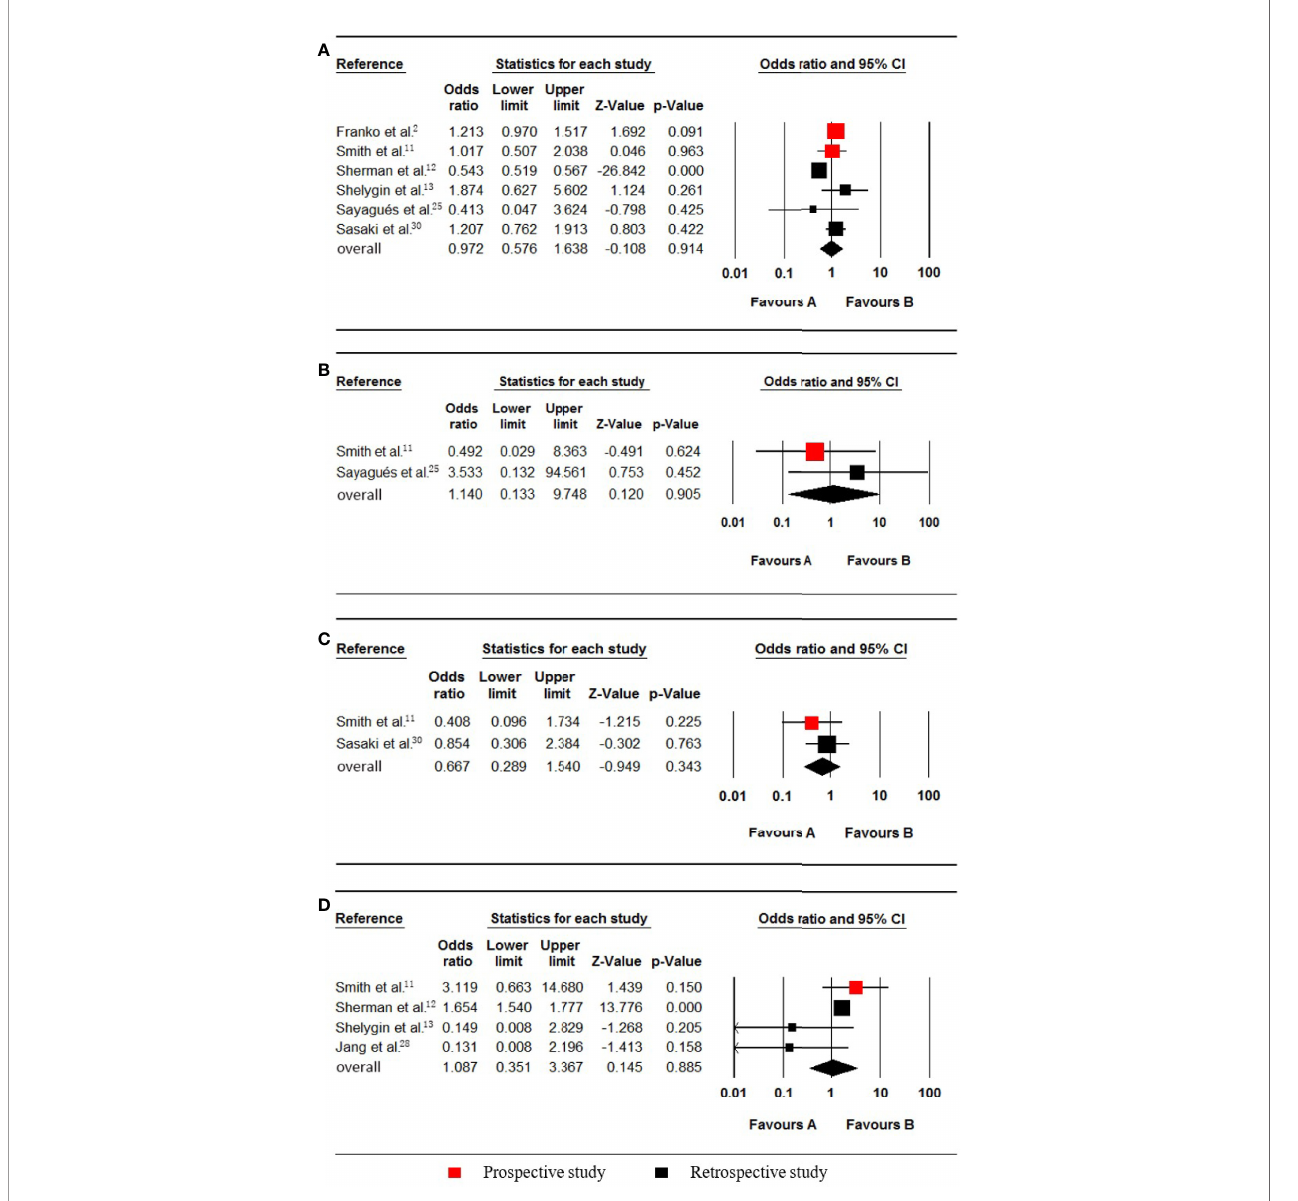
FIGURE 6 | Forest plot for KRAS, NRAS, PIK3CA and MSI-H/dMMR. Favours A, non-pmCRC. Favours B,synchronous pmCRC. (A) KRAS. (B) , NRAS. (C) PIK3CA. (D) ,